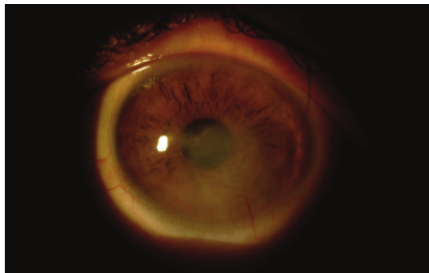
Figure 3: Resolved ulceration and regressed corneal vascularization after